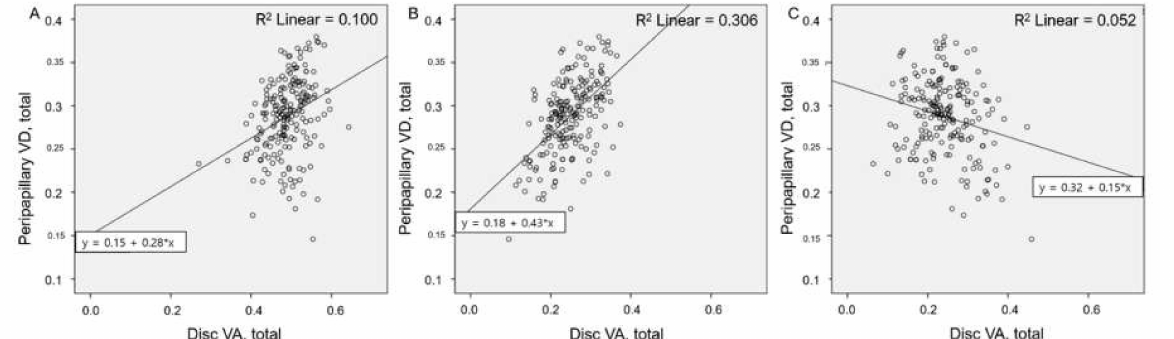
Figure 4. Correlation between disc and peripapillary VDs: ( A , B ) Total and small and medium vessel VDs of the optic disc area were correlated positively with peripapillary VD; ( C ) Larger vessel VD of the optic disc area was correlated negatively with peripapillary